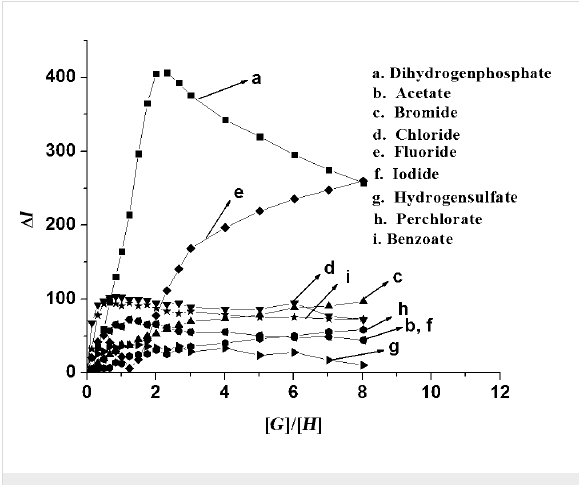
Figure 6: Plot of change in emission of 1 at 420 nm vs the ratio of guest to host concentration in CH 3 CN.